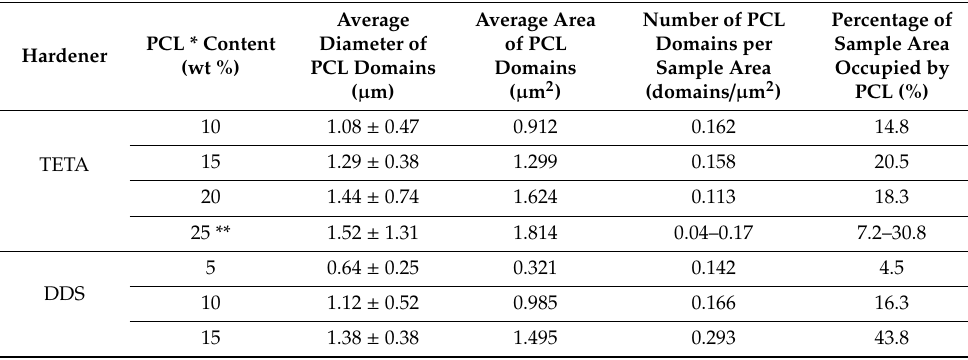
Table 1. Image analysis results of blends